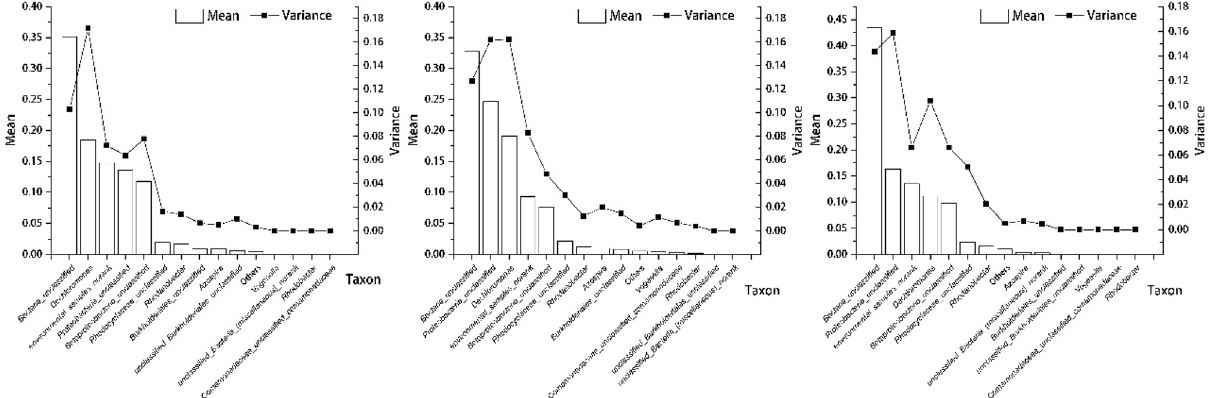
Figure 4. Mean and variance of different denitrifying bacterial taxa in the surface-flow constructed wetland (May, August, and